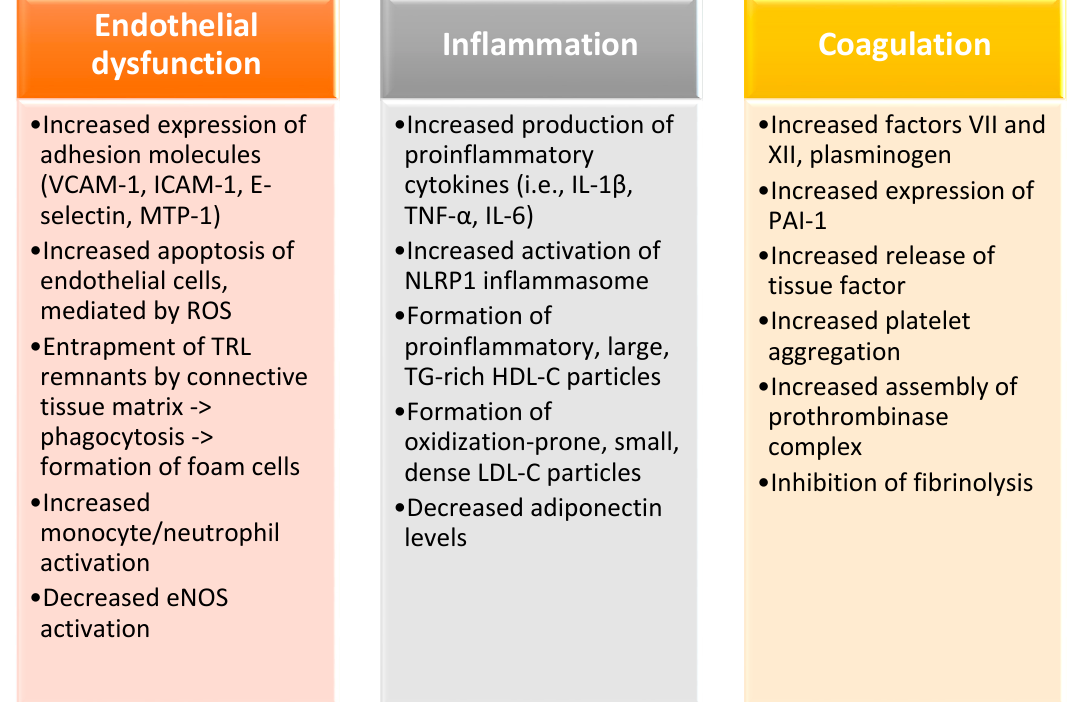
Figure 1. The main mechanisms through which hypertriglyceridemia leads to cardiovascular derangement are endothelial dysfunction, oxidative stress, chronic inflammation, and the induction of a hypercoagulative state. VCAM-1, vascular cell adhesion molecule 1; ICAM-1, intercellular adhesion molecule 1; MTP-1, microsomal triglyceride transfer protein 1; ROS, reactive oxygen species; TRL, triglyceride-rich lipoprotein; eNOS, endothelial nitric oxide synthase; IL-1 β , interleukin 1 β ; TNF- α , tumor necrosis factor α ; IL-6, interleukin 6; TG, triglycerides; HDL-C, high-density lipoprotein cholesterol; LDL-C, low-density lipoprotein cholesterol; PAI-1, plasminogen activation inhibitor-1.